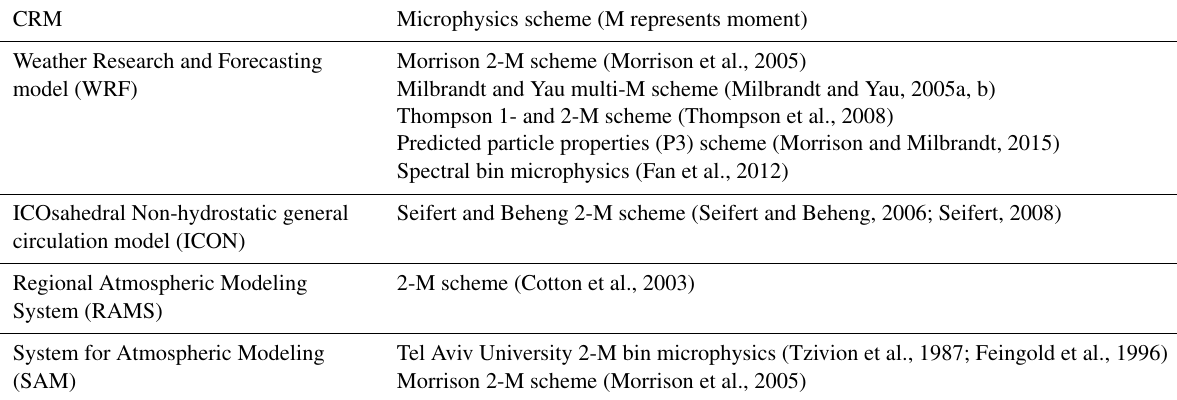
Table 3. Incorporated microphysics schemes and corresponding